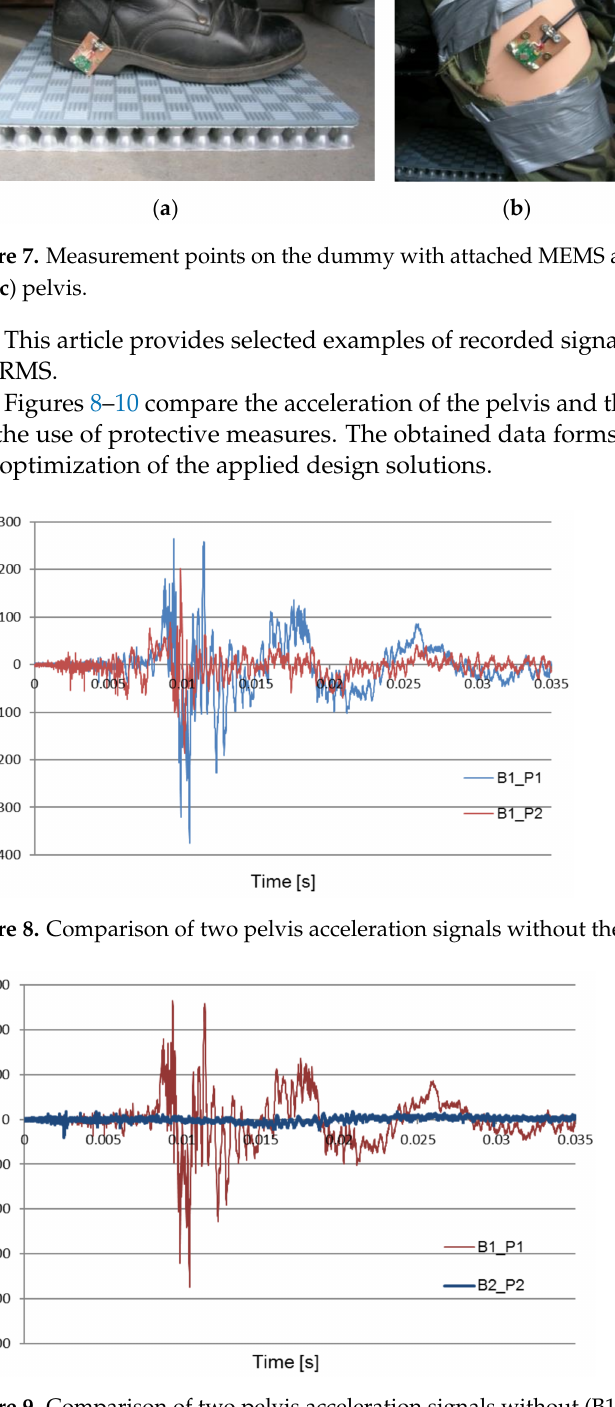
Figure 9. Comparison of two pelvis acceleration signals without (B1_P1) and with (B2_P1) use of the anti-explosive